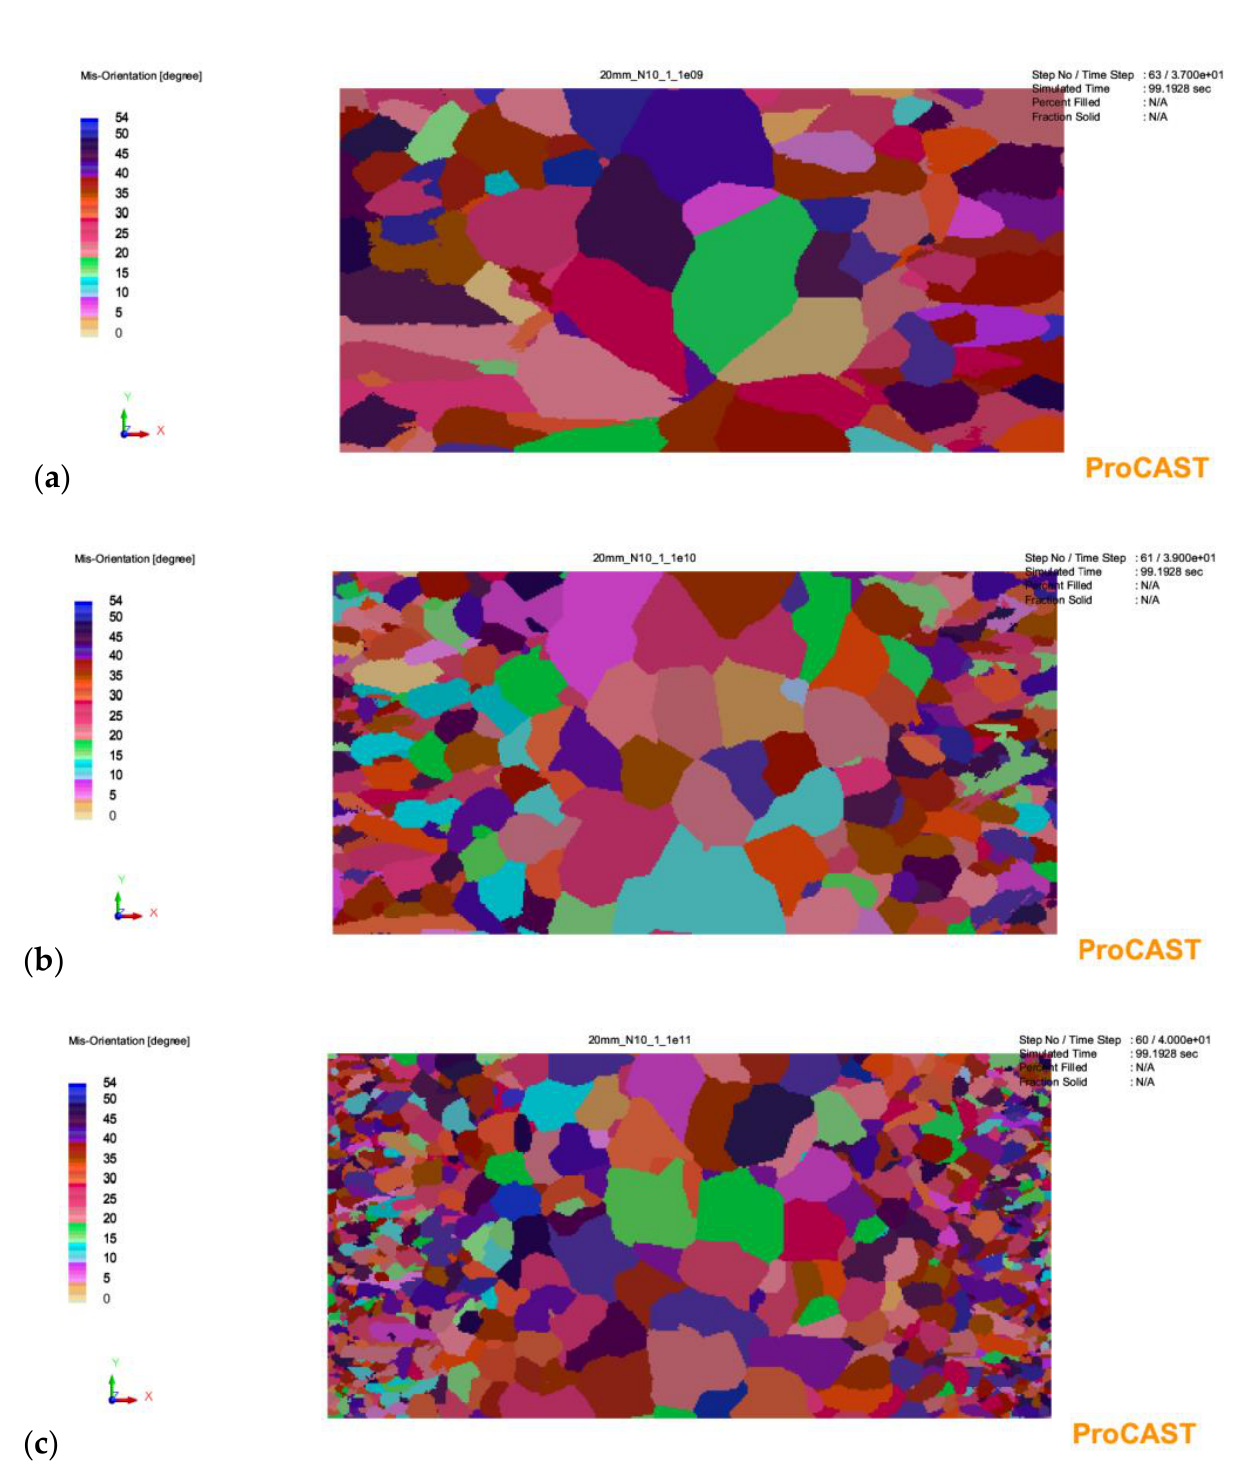
( b ) Figure 2. ( a ) Model of the research casting; ( b ) the appearance of the casting immediately after re- moving the mold. The EBSD microstructure analysis was performed for three thicknesses: 20, 30 and 40 mm. The chemical composition of the inoculated cast iron is presented in Table 3. Table 3. Chemical composition of hypoeutectic chromium cast iron, wt%. Inoculant Addition